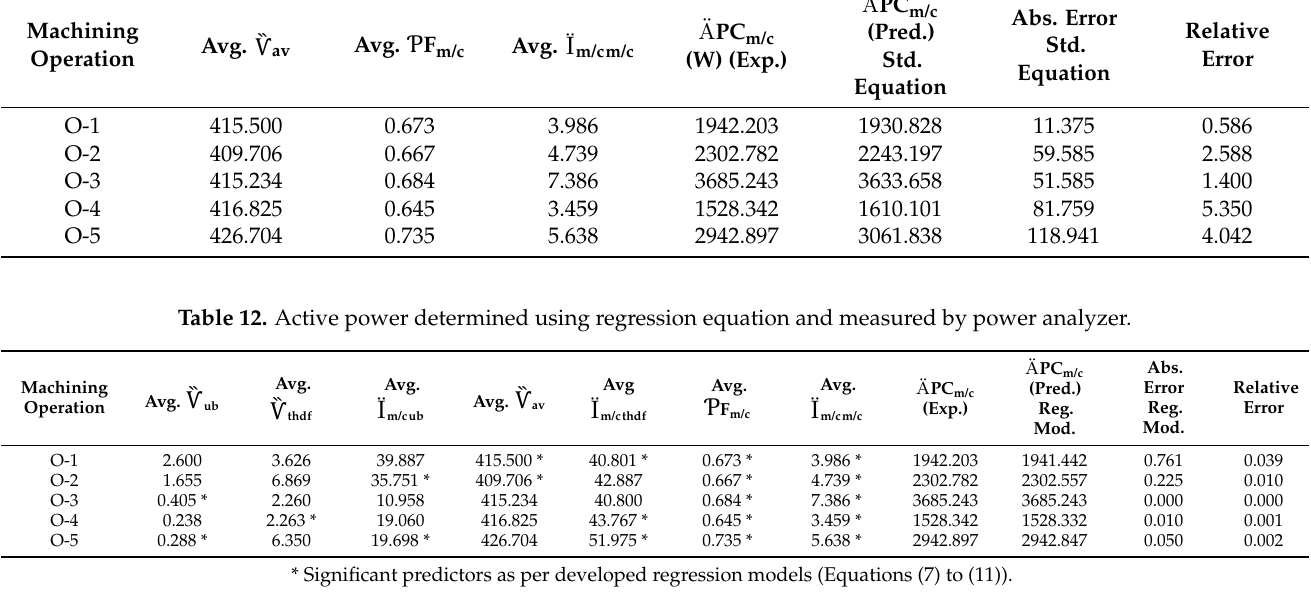
Figure 9a represents the machining operation along the x -axis, relative error along the primary y -axis, and the absolute error along the secondary y -axis. The relative error between the values of active power obtained from the power analyzer and those calculated using the standard Equation (12) is illustrated using a bar chart. The minimum relative error was 0.586 for machining operation O-1, and the maximum relative error was 5.350 for